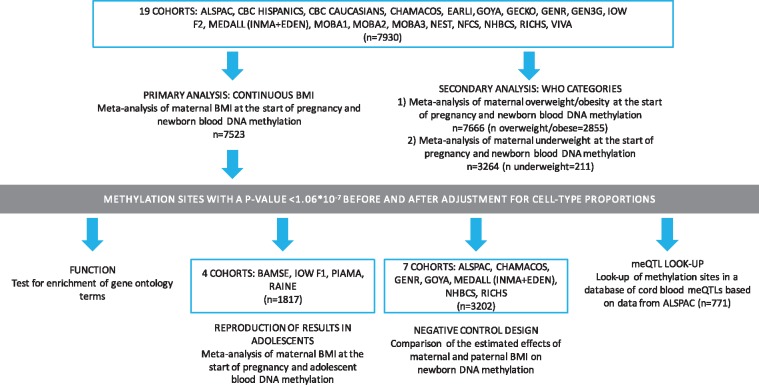
An overview of the study design.